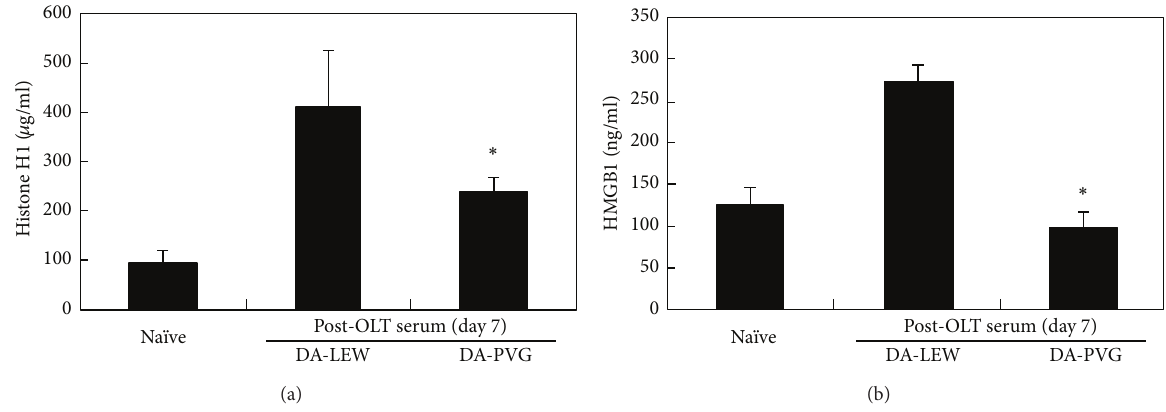
Figure 2: The elevation of circulating histone H1 and HMGB1 during the rejection phase after OLT. The levels of histone H1 and HMGB1 in naive or post-OLT sera were determined by ELISA. For the quantitative determination of histone H1, 0.1 𝜇 g of antihistone H1 polyclonal antibody (Santa Cruz Biotechnology, Santa Cruz, CA, USA) in 100mM NaHCO 3 (pH 9.3) was coated onto a 96-well microtiter plate (Nalge Nunc International, Roskilde, Denmark) by overnight incubation at 4 ∘ C. The plate was then blocked with SuperBlock T20 (PBS) Blocking Buffer (Thermo Fisher Scientific Inc., Rockford, IL, USA), and serum samples (each 𝑛 = 3 ) (50 𝜇 L, × 25 dilution with 10mM Tris-HCl (pH 8.0), 0.9% (w/v) NaCl, 0.5% (w/v) Tween 20) were added to the wells. Calf thymus histone H1 (Upstate, Charlottesville, VA, USA) was used as a standard. The mixture was incubated at room temperature for 1hr. Antihistone H1 monoclonal antibody ( × 500 dilution; Abcam, Cambridge, MA, USA) was then added, and the mixture was incubated at room temperature for 1hr. Peroxidase-conjugated anti-mouse IgG ( × 2,000 dilution; Santa Cruz Biotechnology) was then added, and the mixture was incubated at room temperature for 1hr, followed by the addition of 1-Step Ultra TMB substrate solution (Thermo Fisher Scientific Inc.). For the quantitative determination of HMGB1, a rat HMGB1 ELISA kit (MyBioSource Inc., San Diego, CA, USA) was used according to the manufacturer’s protocol. The absorbance (450nm) was then measured using a Victor X4 Multilabel Plate Reader (PerkinElmer, Shelton, CT, USA). The results are expressed as the mean of three individuals ± SD. ∗ Significantly different compared with the DA-LEW combination ( 𝑃 < 0.01 , Student’s 𝑡